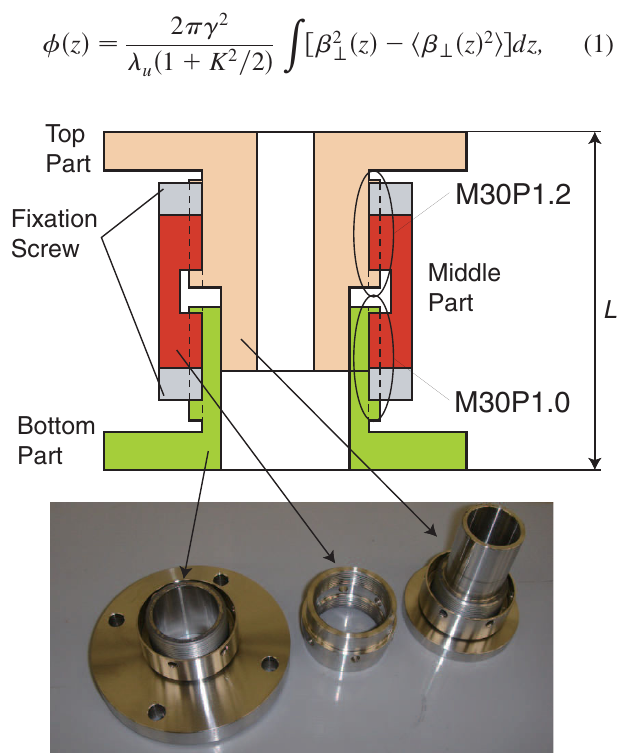
FIG. 2. (Color) Schematic illustration of the new out-vacuum shaft, or ‘‘differential